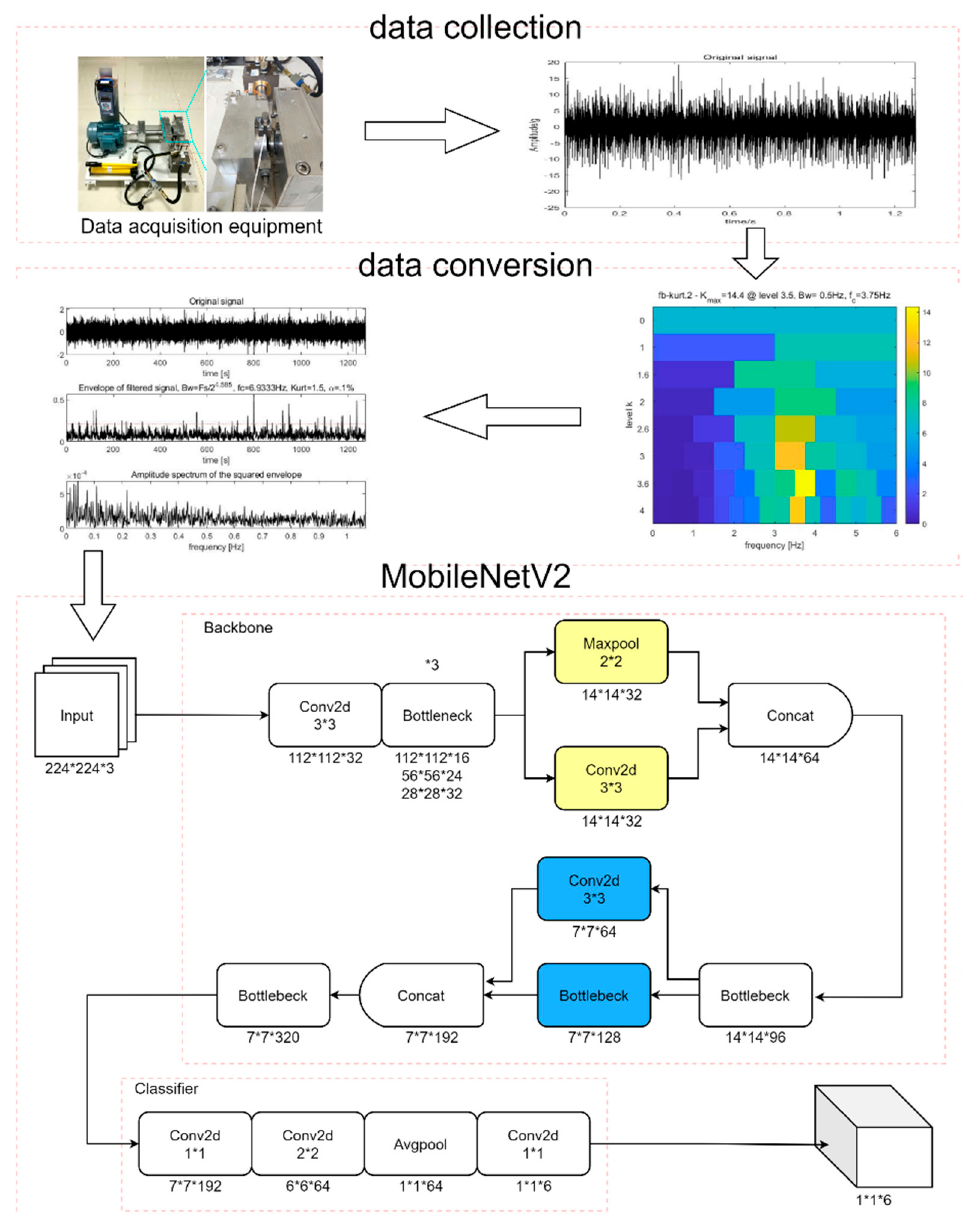
Figure 5. Flowchart of the Proposed Method.